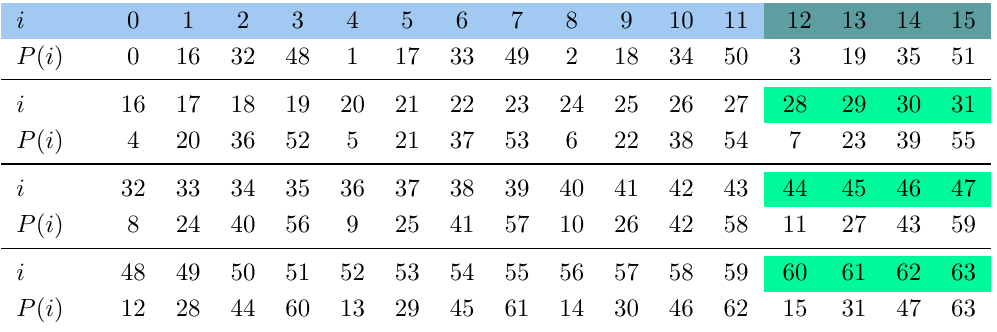
Table 7: Specifications of PRESENT bit-permutation layer. Vertical matrix M 3 and a horizontal matrix N 0 are colored with green and blue colors respectively and their shared bits are colored with dark